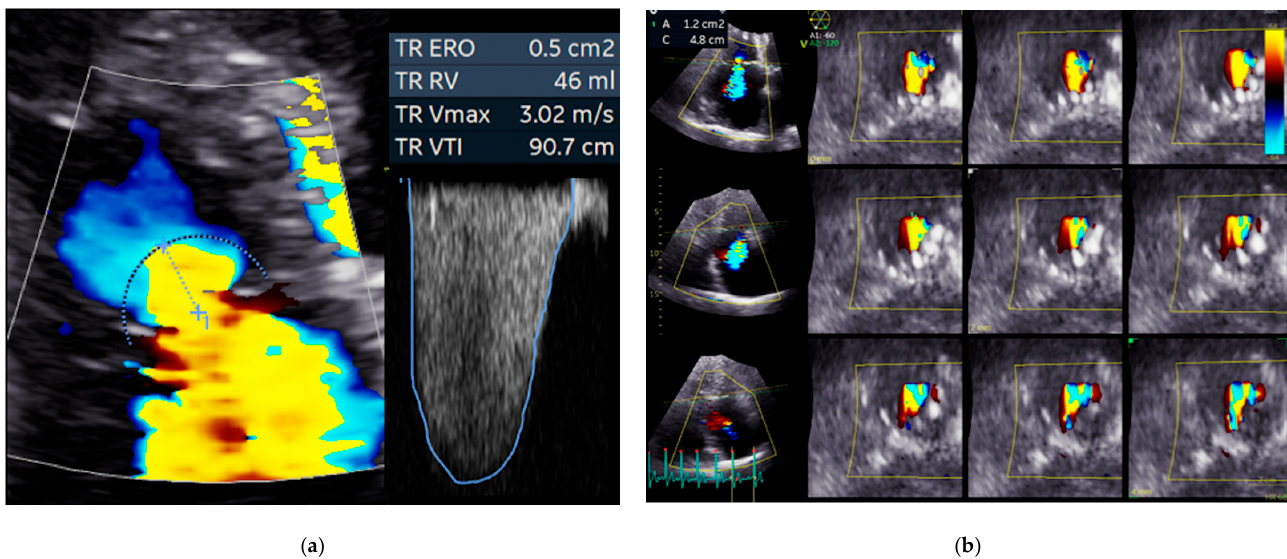
Figure 2. Quantitative assessment of functional tricuspid regurgitation severity by Color-Doppler echocardiography. ( a ) 2D PISA method. ( b ) 3D vena contracta area. Abbreviations: 2D, two- dimensional echocardiography; 3D, three-dimensional echocardiography; A, area; C, circumference; ERO, effective regurgitant orifice area; RV, right ventricle; TR, tricuspid regurgitation; Vmax, maximal regurgitant velocity; VTI, velocity-time integral. Moreover, in patients with A-FTR qualitative signs of TR severity may be misleading: